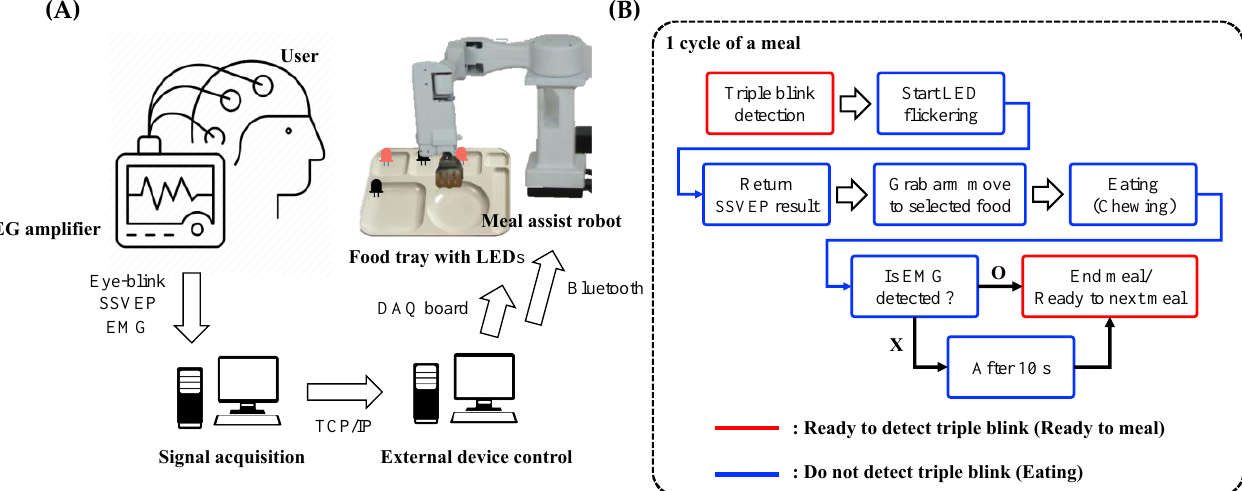
Figure 7. Schematic of hybrid brain – computer interface-based meal-assist robot system. (A) Graphical flow chart for used devices. (B) Flow chart for actual process including triple blink, Electroencephalogram (EEG) for steady-state evoked potential (SSVEP) and electromyogram (EMG).